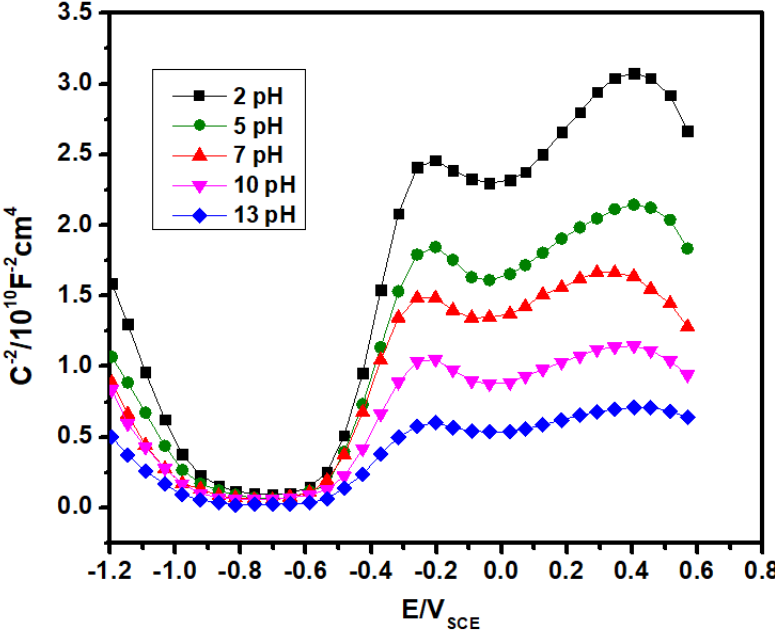
Figure 10. The Mott–Schottky plots for passive films recorded at different pH solution values for 2205 duplex stainless-steels. 2205 duplex